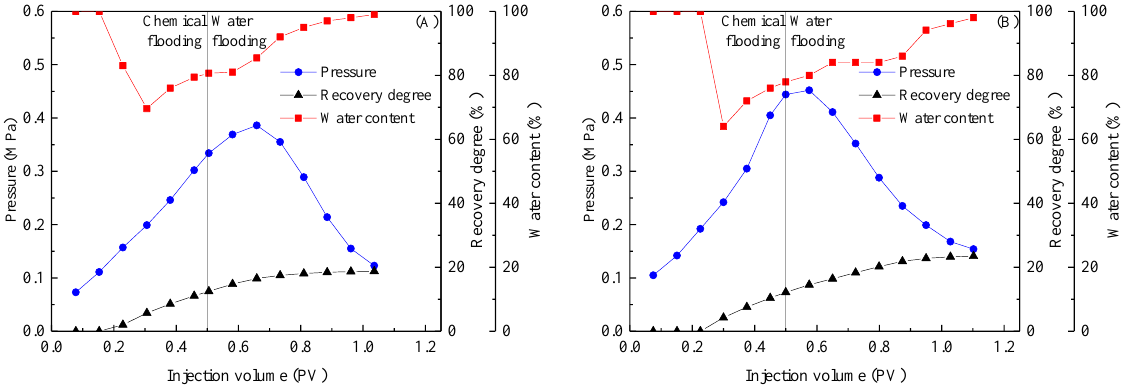
Figure 13. Oil displacement tests with isoconcentration chemical systems: 0.3% KPS + 1500 ppm 1100 W HMPAM ( A ), 0.3% (BSB/Z1) + 1500 ppm 1100 W HMPAM ( B ).